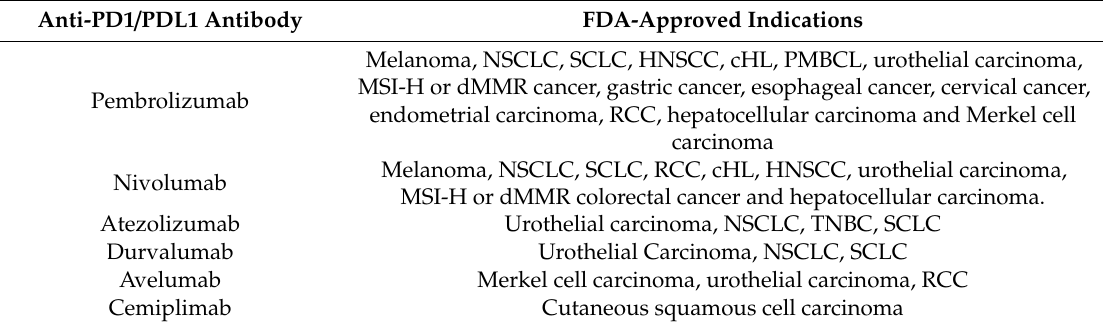
Table 1. Anti-PD1 / PD-L1 antibodies approved for clnical